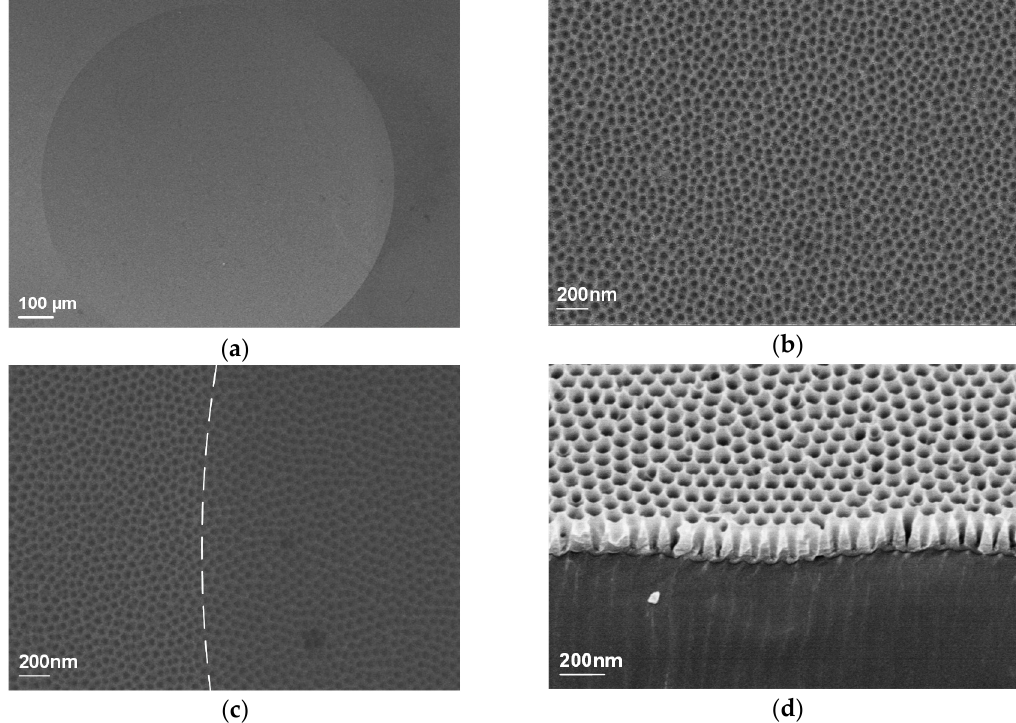
Figure 7. ( a ) SEM images of the nanostructured MLA mold. ( b ) High-magnification SEM image of the lenslet apex region. ( c ) High-magnification SEM image of the lenslet boundary region, with the boundary being indicated by the dashed line. ( d ) Cross-sectional SEM image of the nanopores.